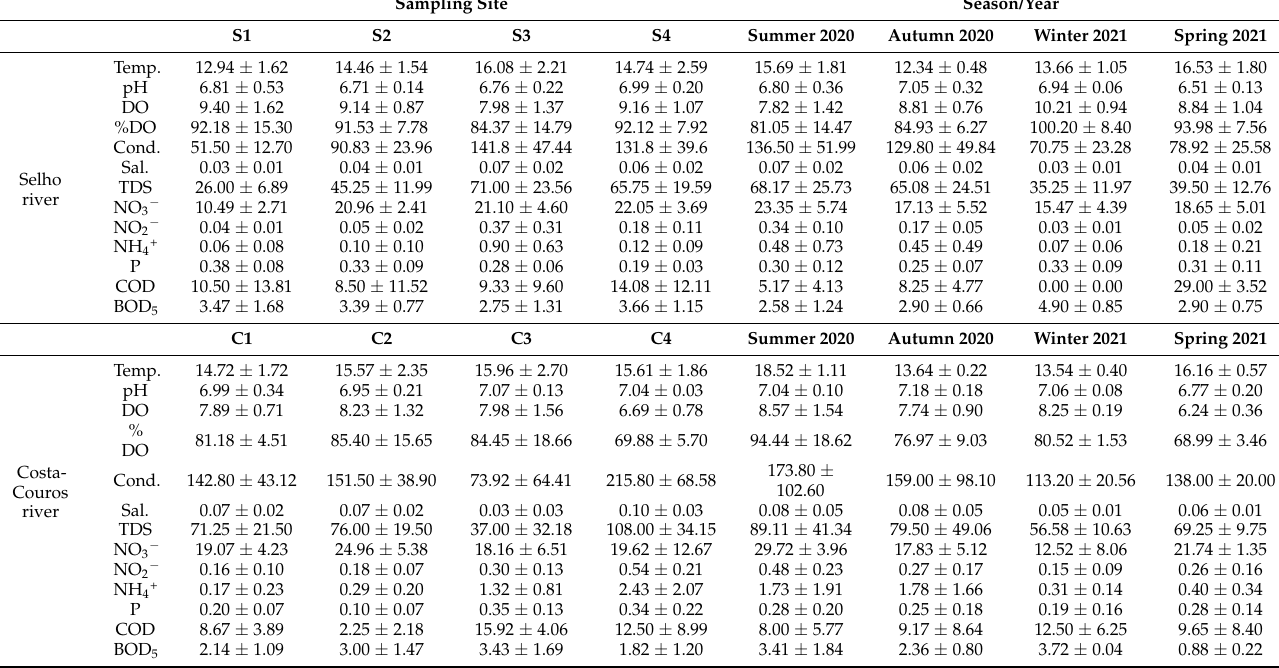
Table 3. Spatial and temporal variation of the physicochemical parameters determined in Selho and Costa-Couros rivers, respectively: water temperature (Temp., ◦ C), pH, dissolved oxygen concentra- tion (DO, mg O 2 /L), percentage saturation of dissolved oxygen (%DO), conductivity (Cond., µ S/cm), salinity (Sal., PSU), total dissolved solids (TDS, mg/L), nitrates (NO 3 − , mg/L), nitrites (NO 2 − , mg/L), ammonium ion (NH 4+ , mg/L), total phosphorus (P, mg/L), chemical oxygen demand (COD, mg/L), and biochemical oxygen demand (BOD 5 , mg/L). Data are presented as the mean ±